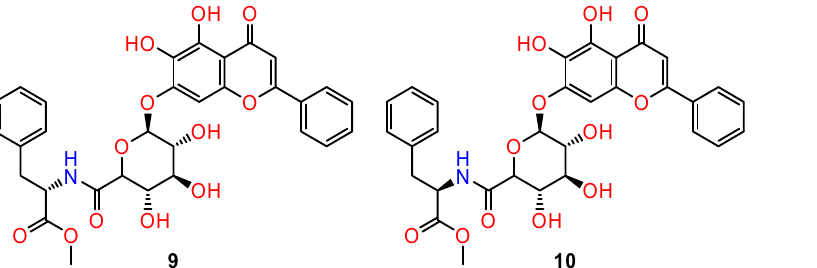
Figure 9. The structures of chiral baicalin derivatives formed from baicalin and phenylalanine methyl esters-BAL ( 9 ) and BAD ( 10 ).